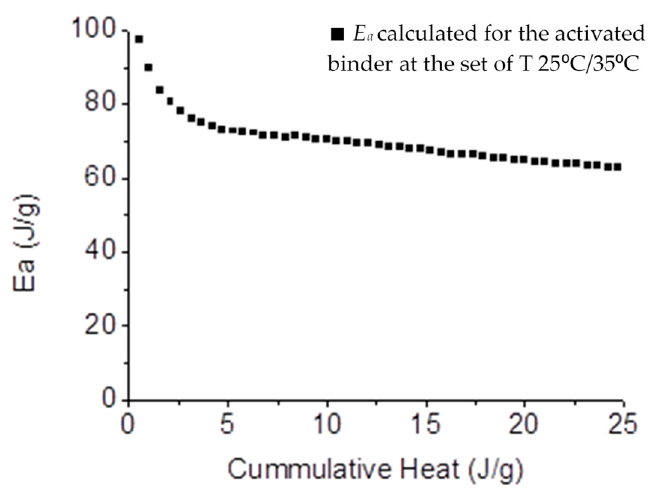
Figure 4. Evolution of the E a of the activated binder determined by Equation (6), at the set of temperatures 25 °C and 35 °C.